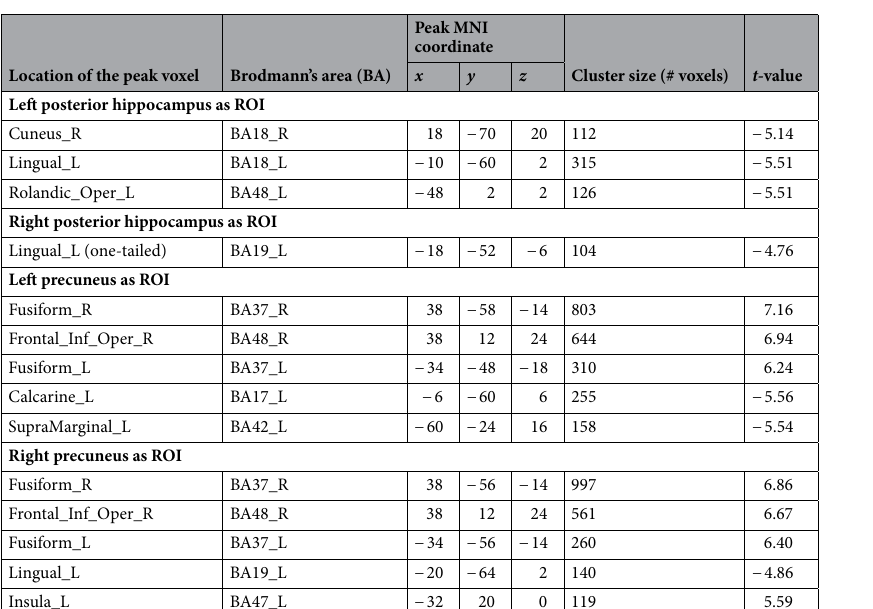
Figure 4. Task-dependent functional connectivity obtained from PPI analysis. ( a ) Left posterior hippocampus as the ROI; ( b ) left precuneus as the ROI; ( c ) right precuneus as the ROI. ( d ) A potential model for social navigation. Blue line indicates negative functional connectivity; Red line indicates positive functional connectivity. pHIP posterior hippocampus, dlPFC dorsolateral prefrontal cortex, Frontal_Inf_Oper the opercular part of the inferior frontal gyrus, L (R) left (right) hemisphere.